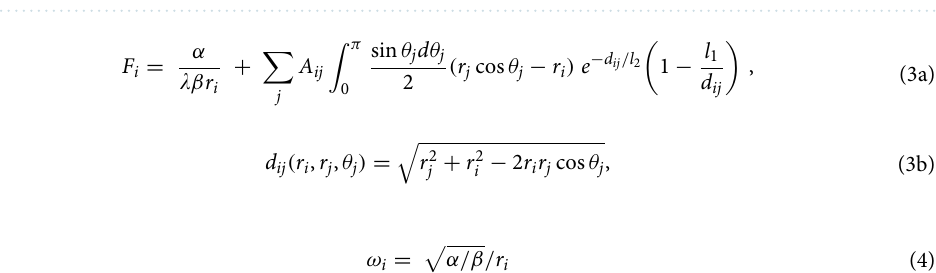
Figure 3. Distance from a swarm’s center versus coupling for agents with the lowest degree in their network. ( a ) Power-law network where simulation-determined values are plotted with red circles and squares for two agents that are directly connected and ejected at the first shedding transition. Mean-field predictions from solving Eqs. (3a–3b) are drawn for each node with solid and dashed lines: stable (red) and unstable (blue). The inlet panel shows the same plot zoomed-in to the bifurcation. ( b ) Similar plot for a Waxman network topology, where only one agent is shed. Other model parameters are identical to Fig.